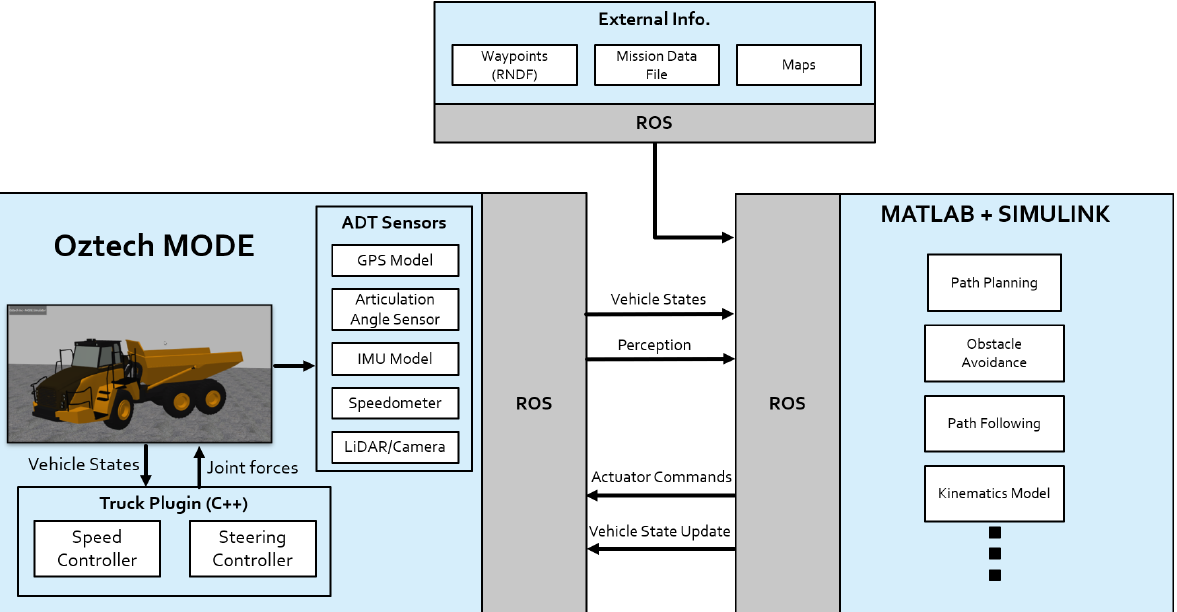
Figure 7. Integration with MATLAB and